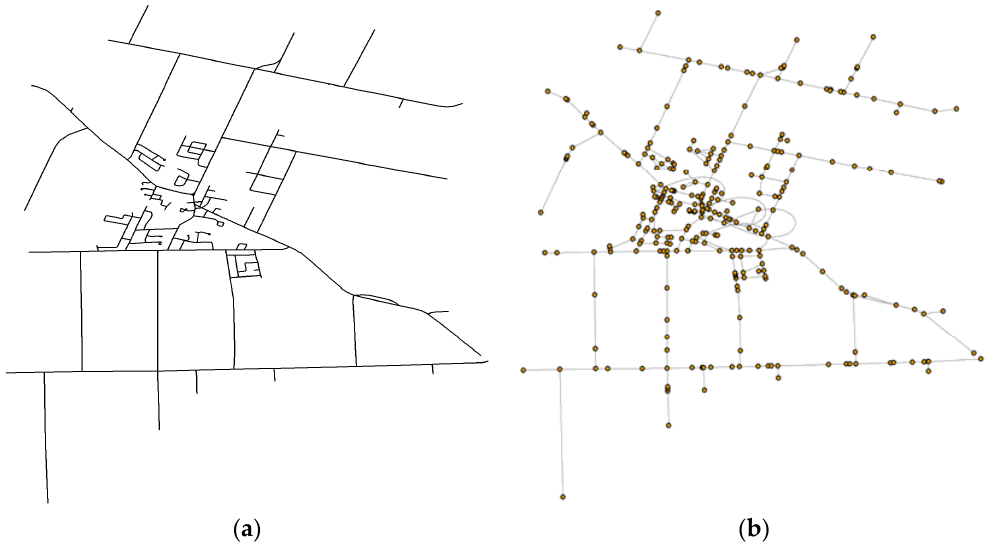
Figure 1. Network to graph conversion by taking all the endpoints or junctions as vertices (Ontario road data). ( a ) The ORN spatial network, ( b ) The resultant ‘ igraph ’ graph.